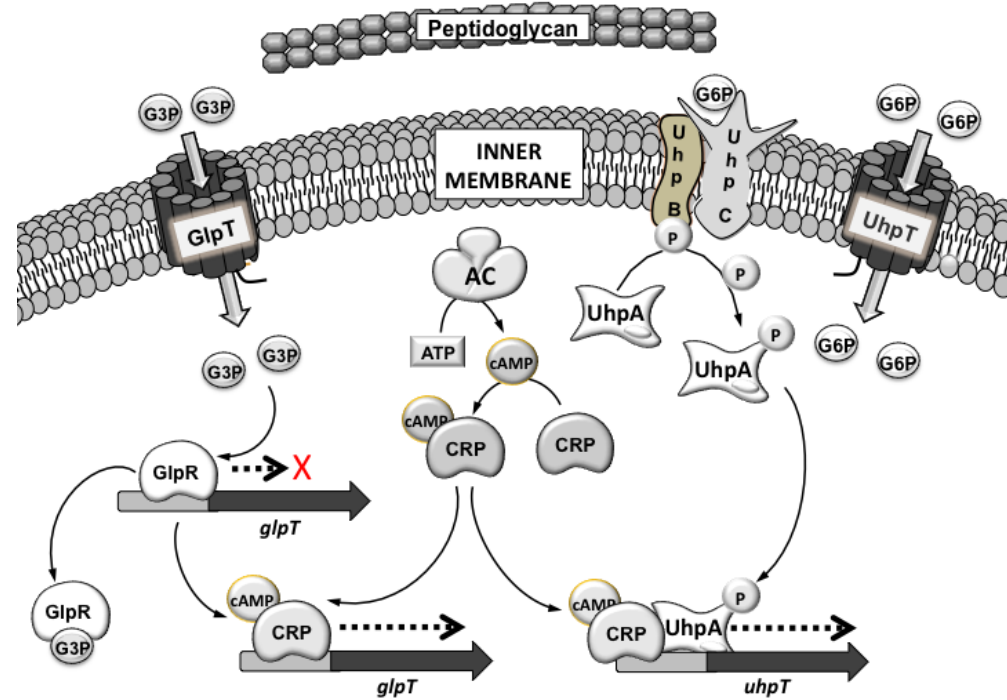
Figure 3. Regulation of GlpT and UhpT. In E. coli and several Enterobacteria, the expression of glpT and uhpT requires the presence of the cAMP, which together with the receptor protein complex (CRP) forms the cAMP receptor protein complex (cAMP-CRP). This complex binds to the specific promoter sites of both genes, glpT and uhpT , and promotes their expression. Both transporters experience additional regulation. On the one hand, glpT gene expression is also controlled by the repressor, GlpR, which becomes inactive when it is bound to glycerol-3-P (G3P), and on the other hand, of uhpT ; high-level expression also requires the regulatory genes, uhpA , uhpB and uhpC , which sense and transduce signals by phosphorylation when hexose phosphates are detected, thereby positively regulating the transcription of the